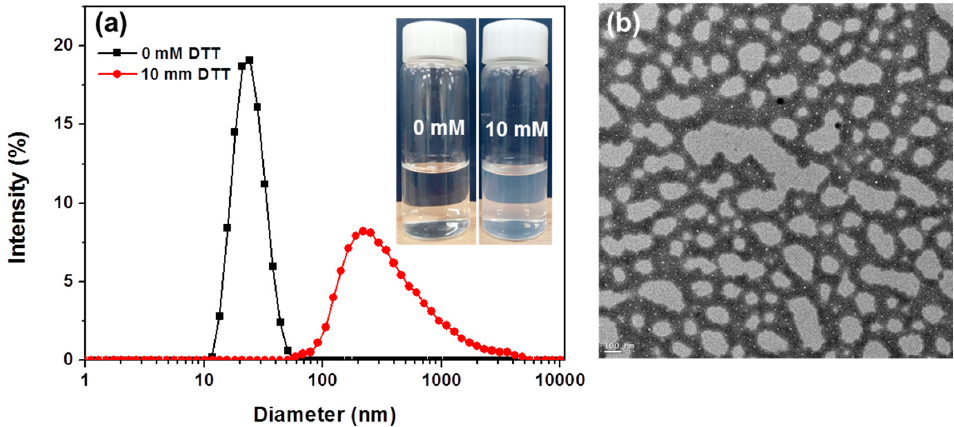
Figure 6. ( a ) Dynamic light scattering (DLS) plots of poly(ethylene glycol)-cholesteryl conjugate (Chol-ss-PEG-ss-Chol) micelles incubated in aqueous buffer solution (control) and 10 mM DL -dithiothreitol (DTT) buffer for 6 h (inset shows digital photographs before and after 10 mM DTT treatment); and ( b ) transmission electron microscopy (TEM) image negatively stained with phosphotungstic acid hydrate after DTT treatment (scale bar, 100 nm).